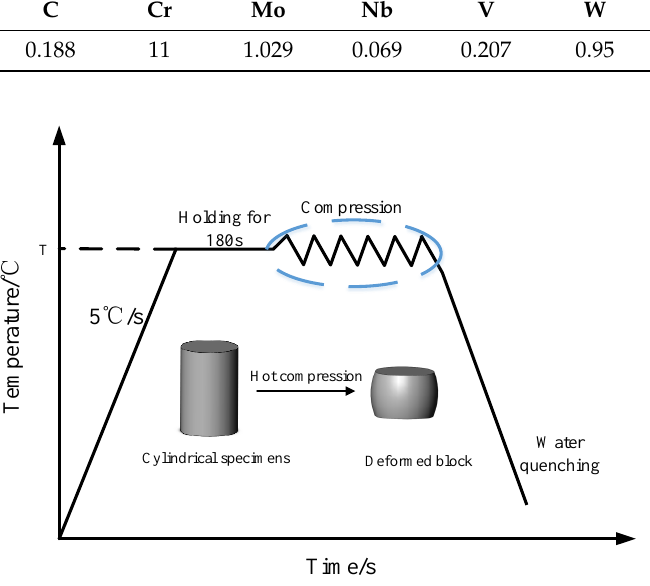
Table 1. Chemical composition of X12 ferritic heat-resistant steel (mass percentage: wt.%).